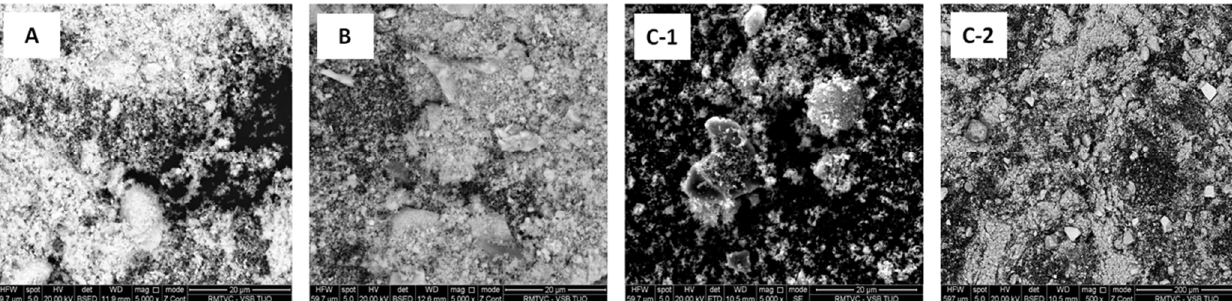
Figure 3. Grain size distribution of pigment: (1) SP1 (red); (2) SP2 (light brown); (3) SP3 (dark brown).